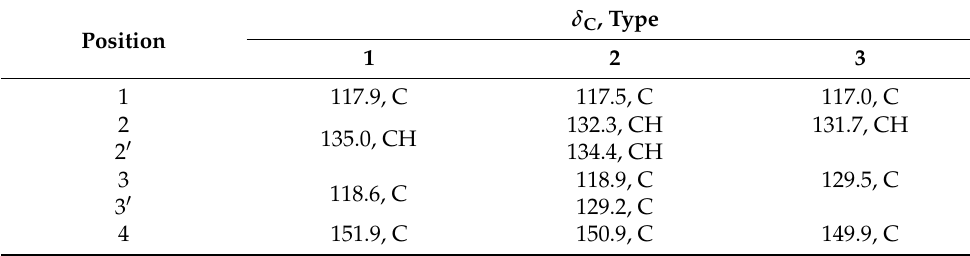
Table 2. 13 C-NMR spectroscopic data (150 MHz, DMSO- d 6 ) for purpuroines K–M ( 1 – 3